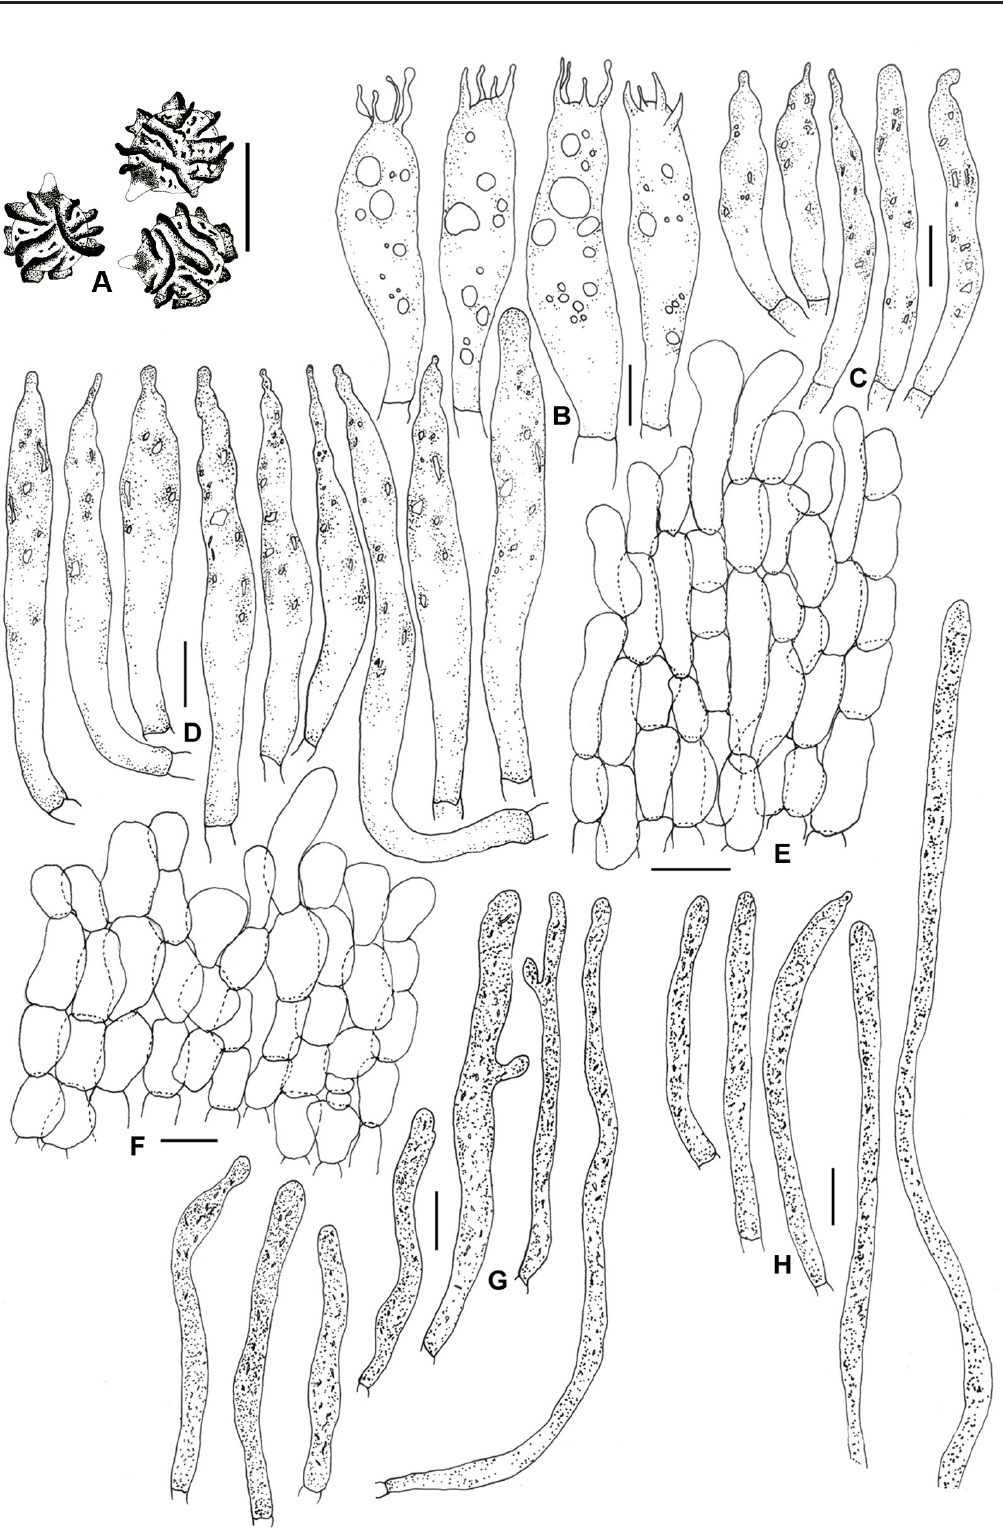
Fig. 6. Russula pseudosenecis A.Ghosh, D.Chakr., K.Das & Buyck sp. nov. (from holotype, AG 20-062 ). A . Basidiospores. B . Basidia. C . Hymenial cystidia near the lamellae edges. D . Hymenial cystidia on the lamellae sides. E . Hyphal terminations in the pileus center. G . Pileocystidia in the pileus center. F . Hyphal terminations near the pileus margin. H . Pileocystidia near the pileus margin. Scale bars: A–H = 10